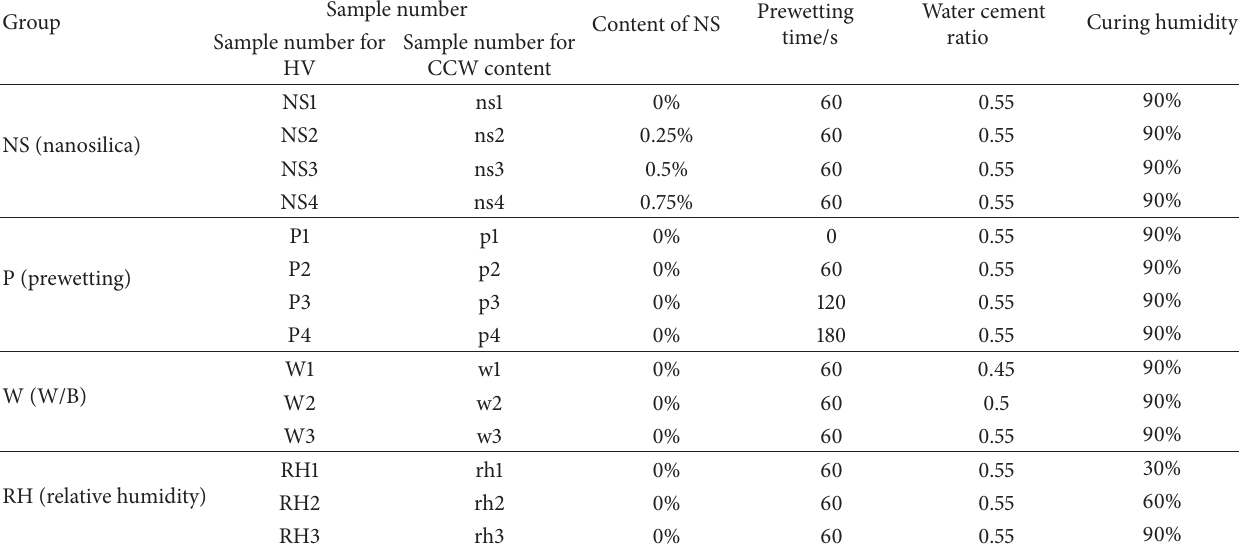
Table 7: Experimental grouping design and mixing ratios.